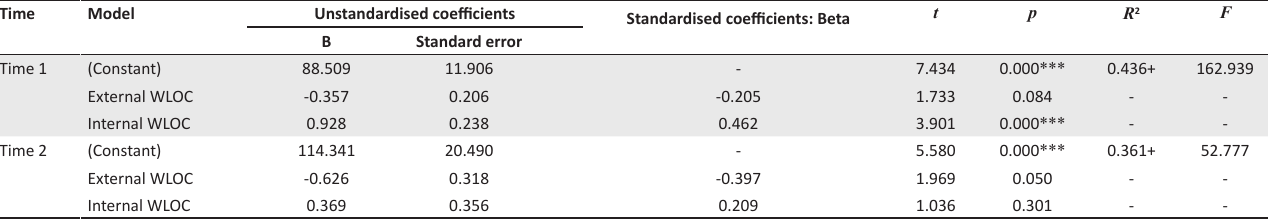
TABLE 6: Multiple regression analysis of PsyCap, external and internal WLOC for Time 1 and Time 2. Time Model Unstandardised coefficients Standardised coefficients: